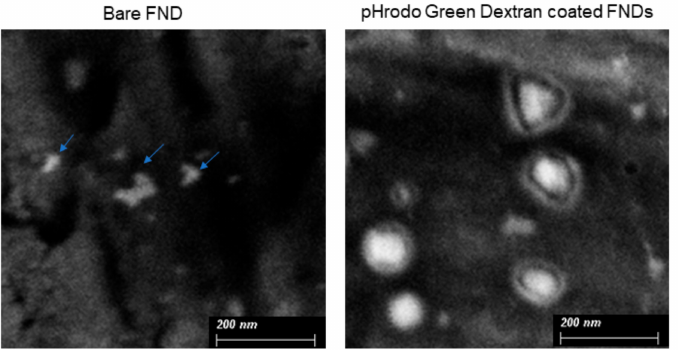
Figure 2. SEM images of bare FNDs and pHrodo Green Dextran adsorbed FNDs from a representative